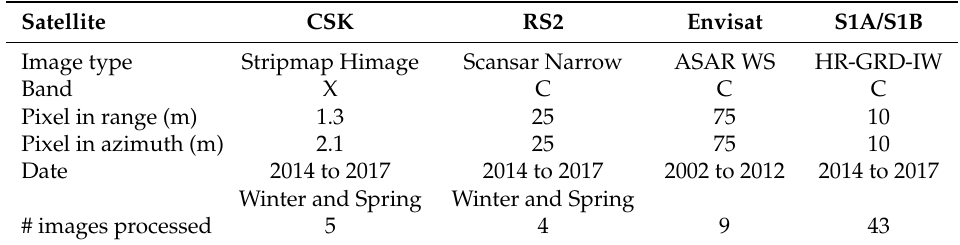
Table 1. Main characteristics of the Synthetic Aperture Radar (SAR) images used in this